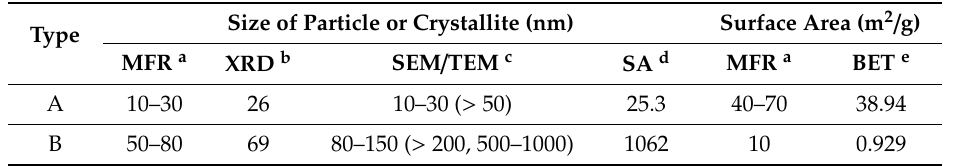
Table 1. The characteristics of the Co-NPs for the experiments reported by the manufacturer (MFR) and as particles determined by several